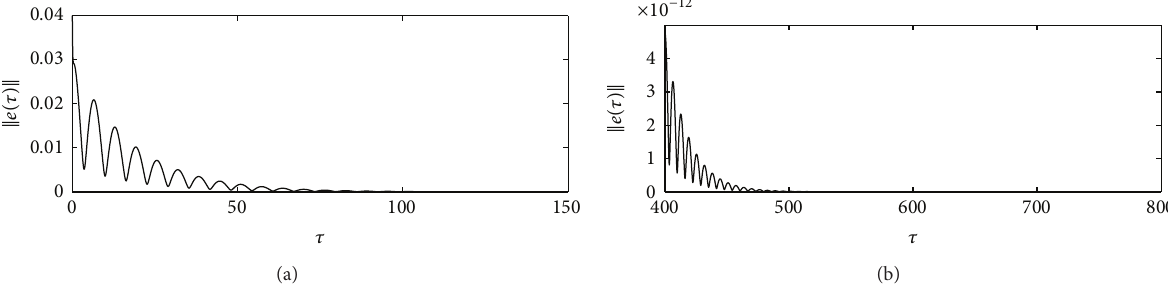
Figure 6: Time evolution of the synchronization errors norm with linear controller